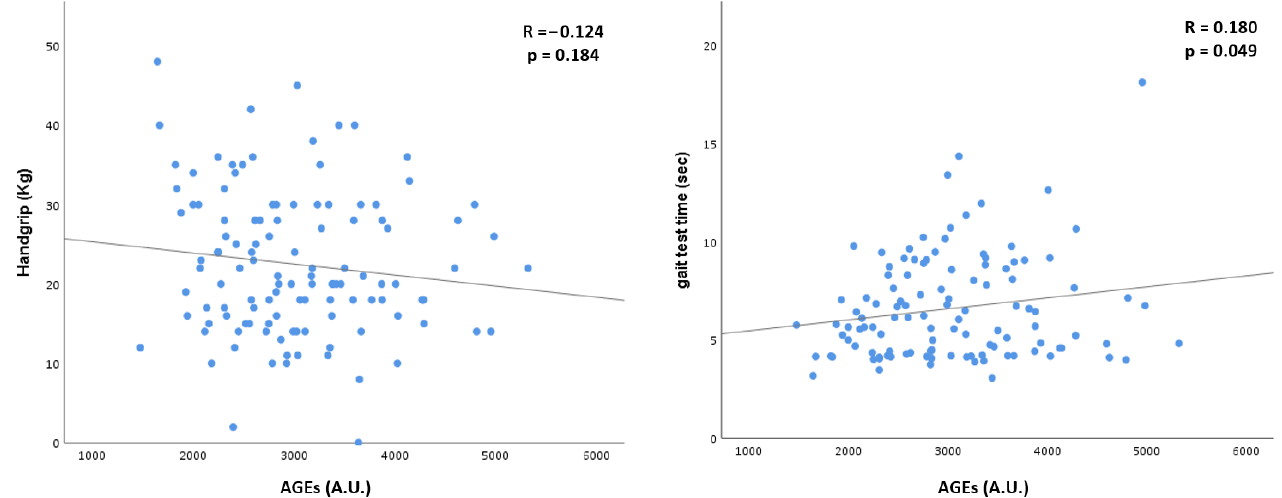
Figure 1. Linear regression model of comparison between AGEs, handgrip strength, and gait test time ; AGEs, Advanced Glycation End-products. time; AGEs, Advanced Glycation